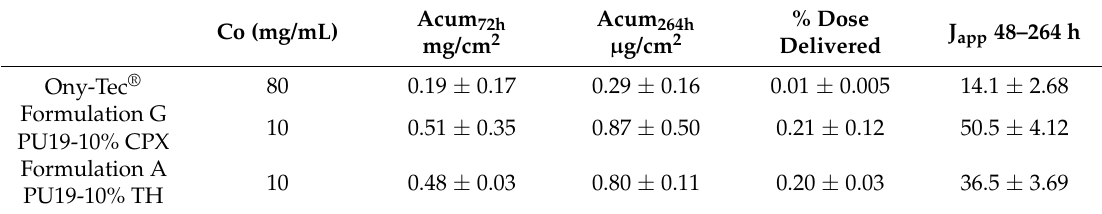
Table 6. Delivery of CPX and TH across nail (mean ± SD, r 2 =